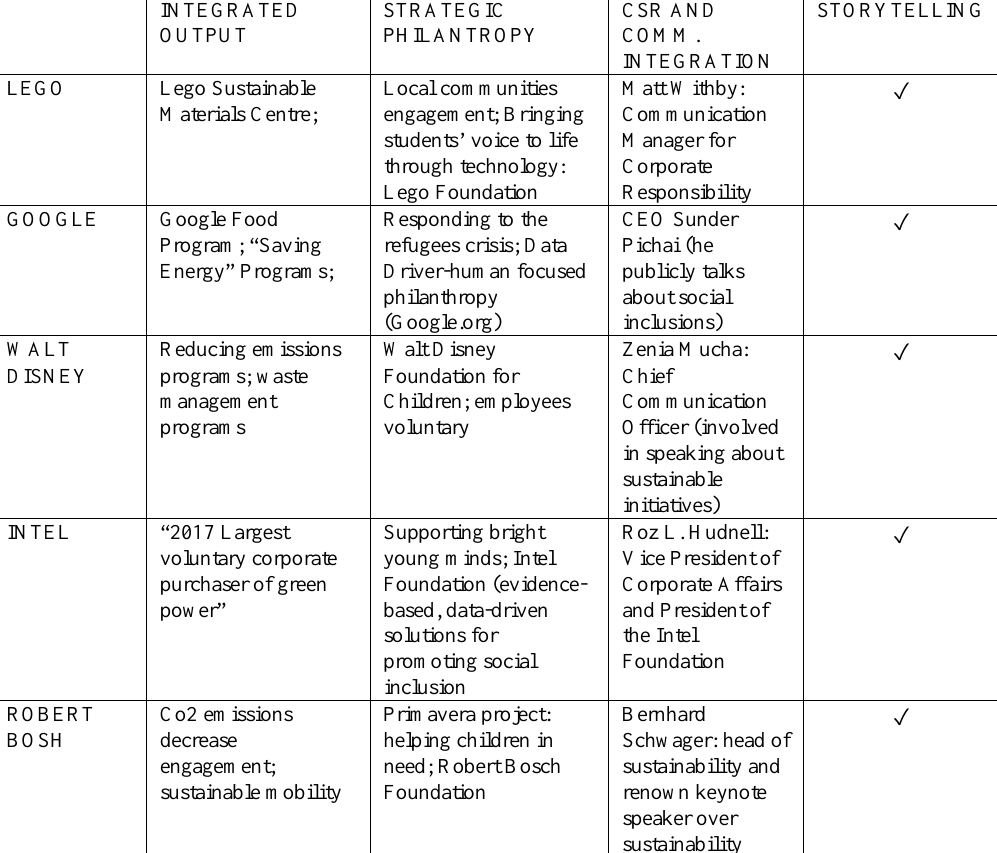
Table 1: International Benchmarking of CSR and Firms